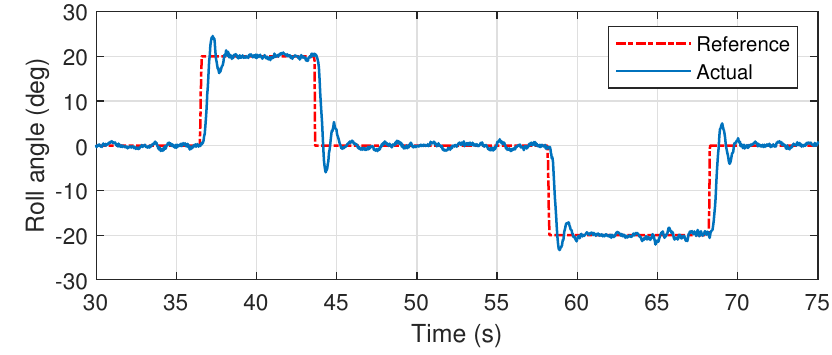
Figure 13. Roll angular response.